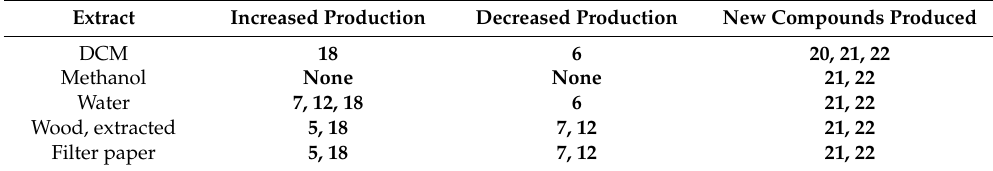
Table 4. A summary of compounds influenced by different extracts of T. disticum a